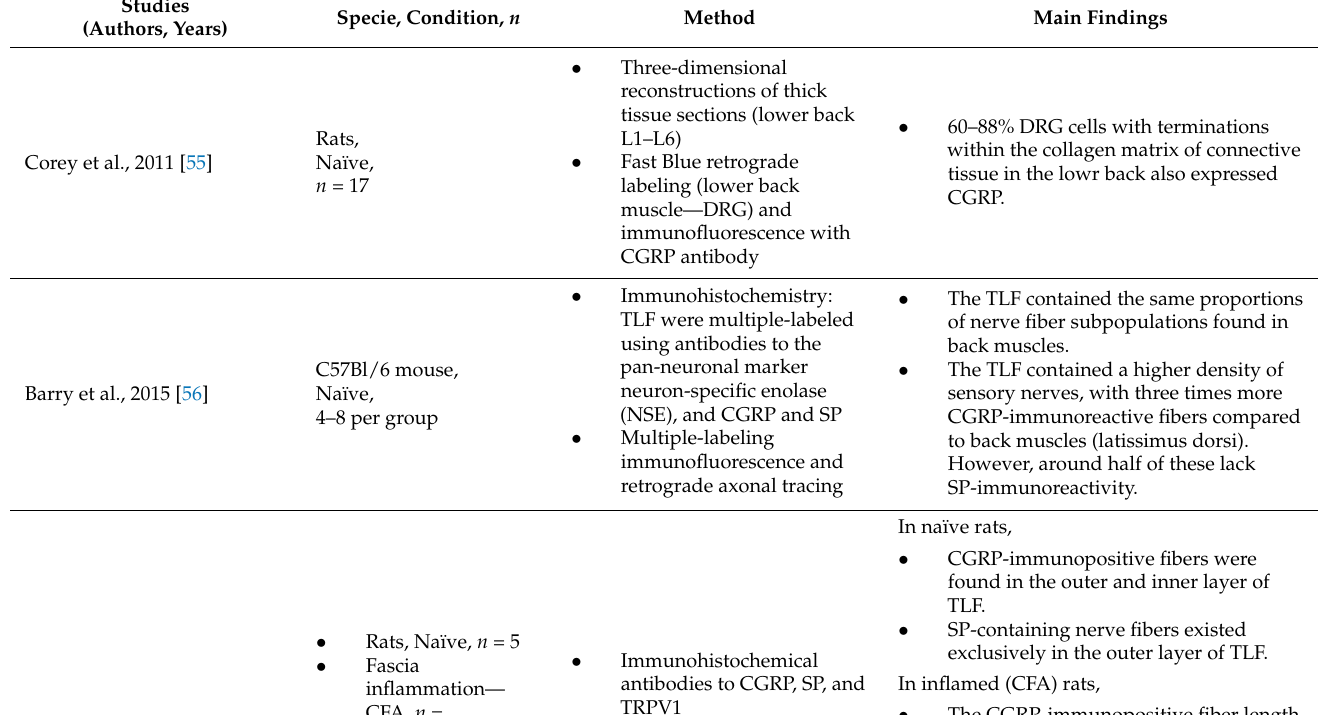
Table 1. Ex vivo